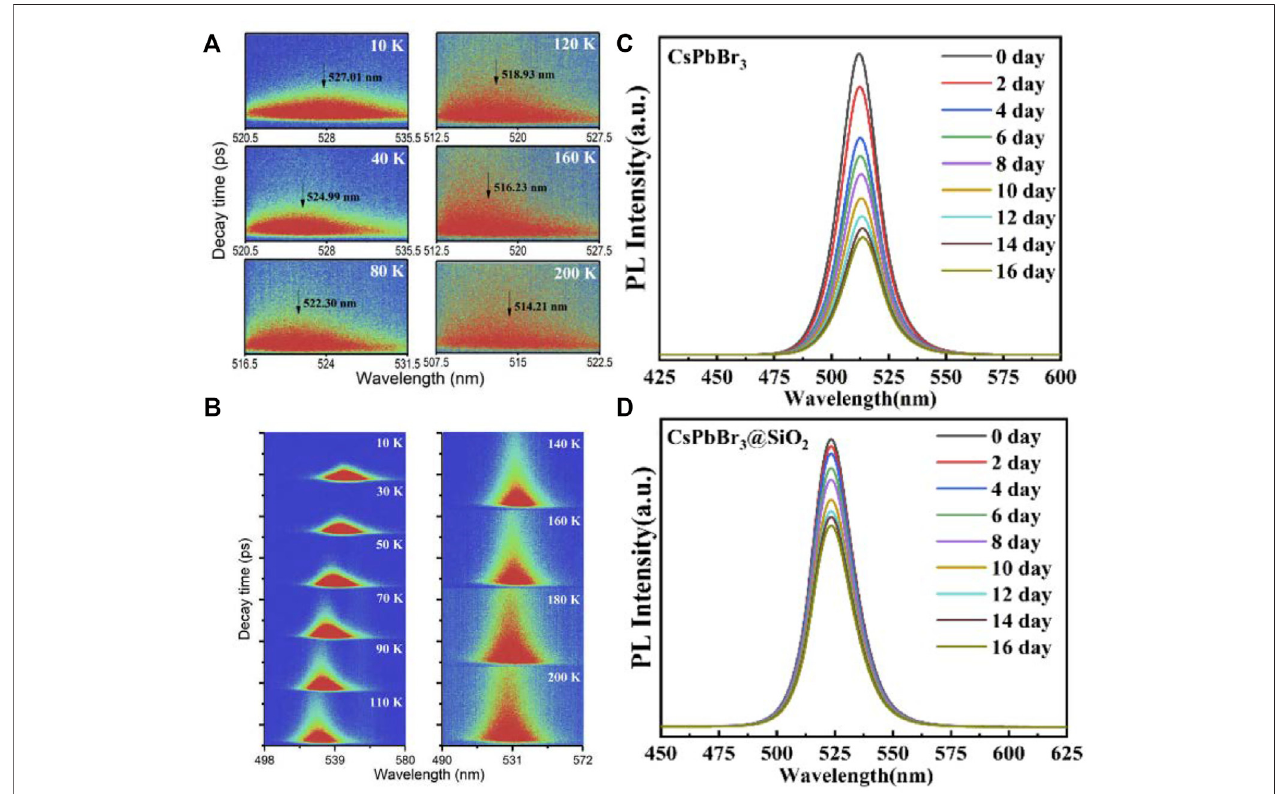
FIGURE 5 | TRPLs of (A) CsPbBr 3 QDs and (B) CsPbBr 3 @SiO 2 QDs at different temperatures; PL spectra of (C) CsPbBr 3 QDs and (D) CsPbBr 3 @SiO 2 QDs measured at different times (Zhang et al.,